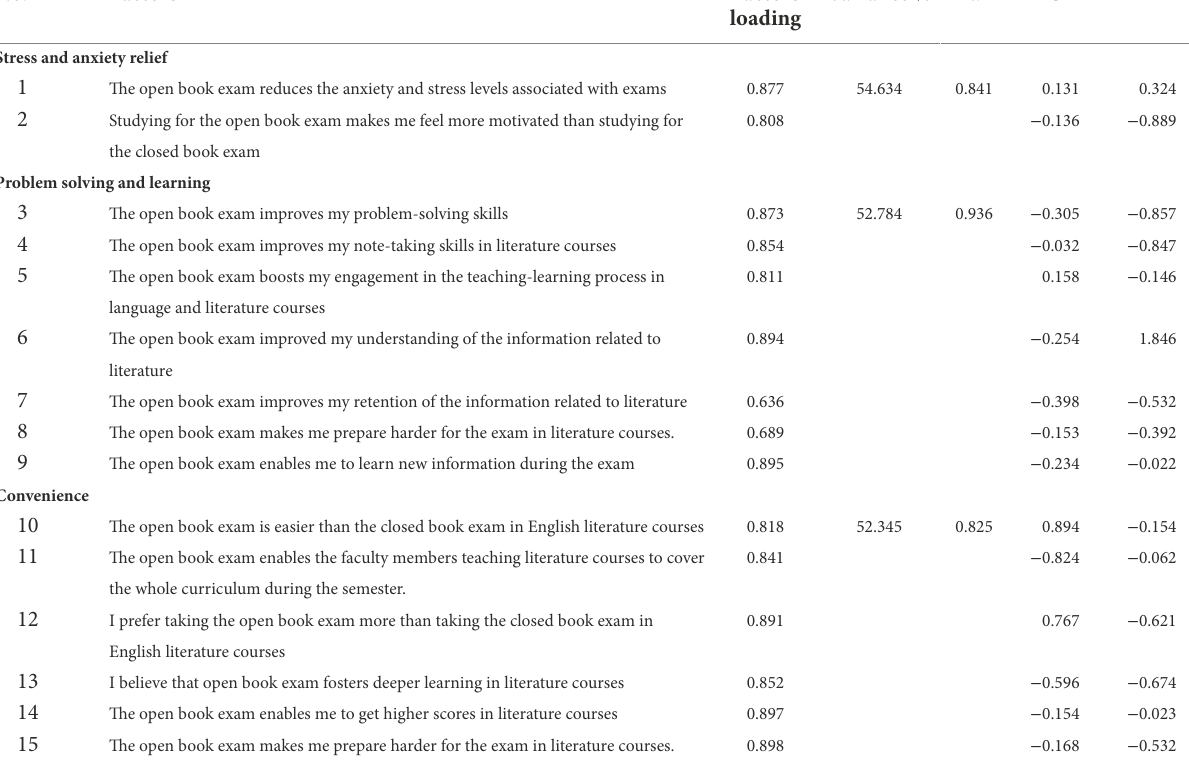
TABLE 1 The results of factor